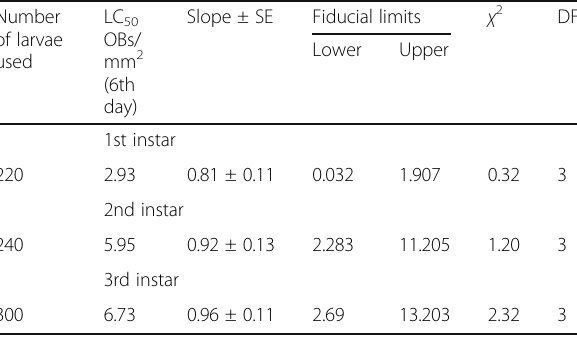
Table 1 Bioassay of Spilosoma obliqua nucleopolyhedrovirus against S.